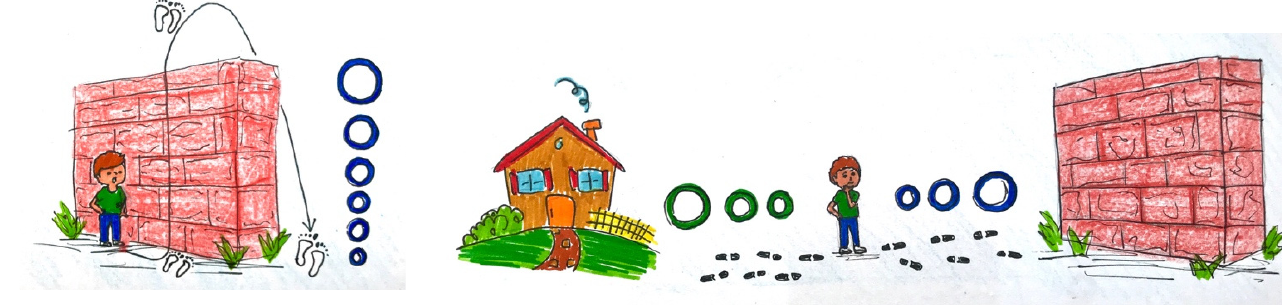
Figure 4. ‘Confidence’ and ‘practice and try again’ items to measure self-efficacy.